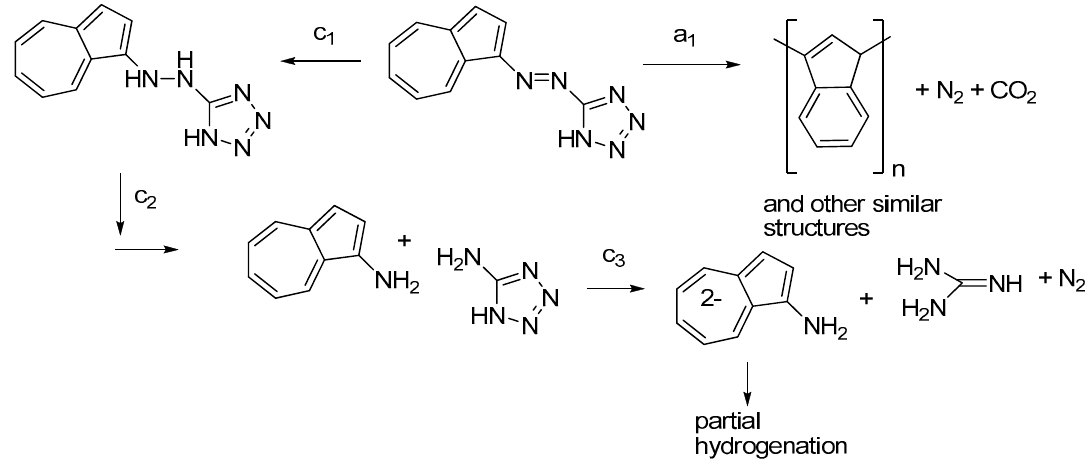
Figure 6. Mechanistic steps in electrochemical oxidation (a1) and reduction (c1, etc.) of L .